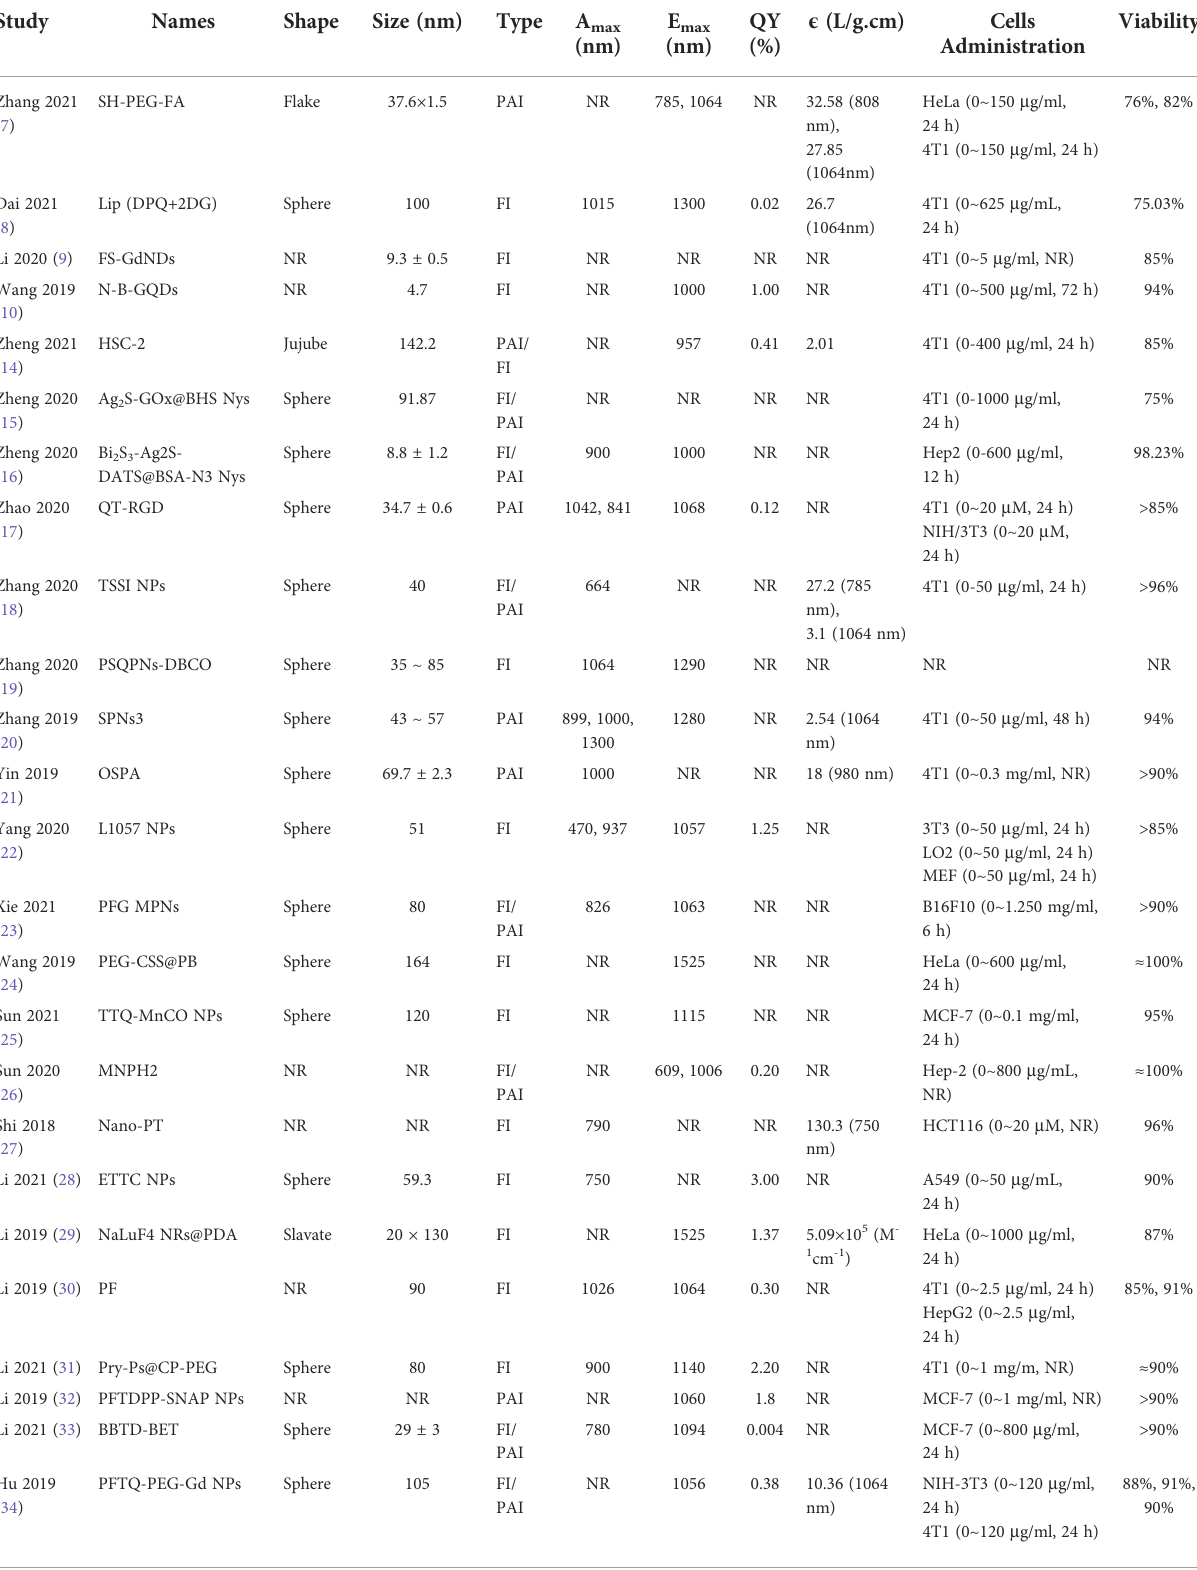
TABLE 1 The basic information of NIR-II probe included in the